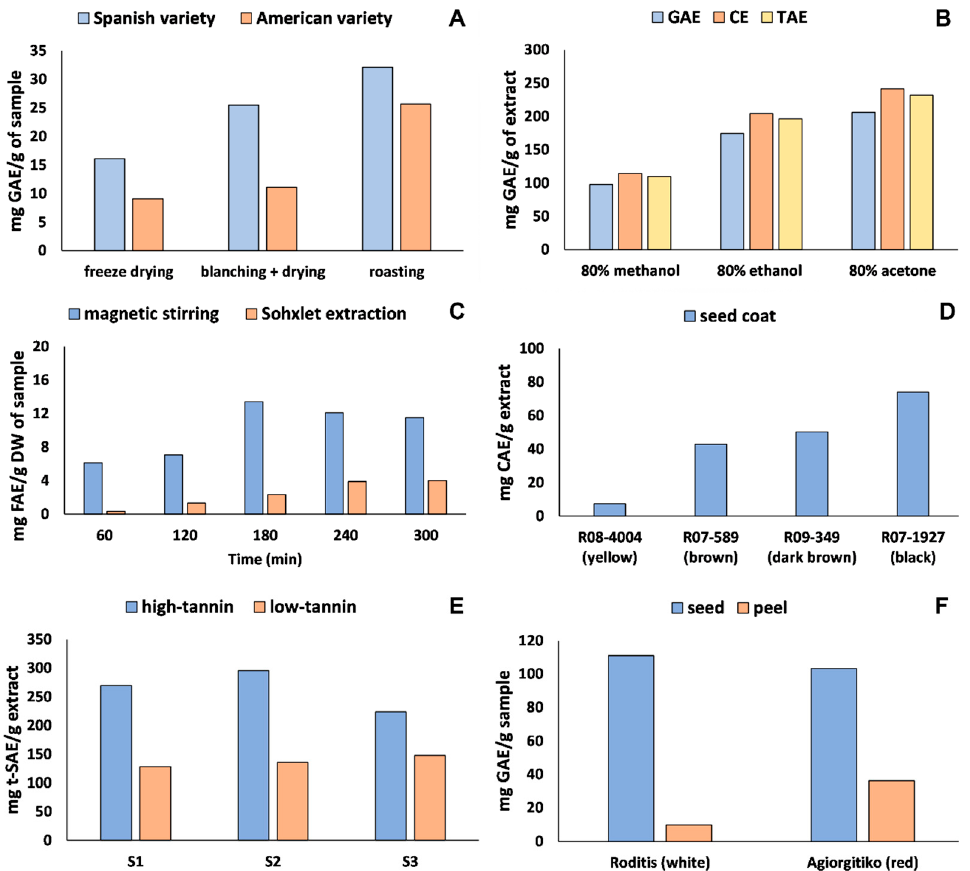
Figure 4. Total phenolics in selected plant food by-products. ( A ) Almond skin [191]; ( B ) hazelnut skin [192]; ( C ) rice husk [193]; ( D ) soybean coat [194]; ( E ) canola (high-tannin) and rapeseed (low-tannin) hull [195], S1, S2, and S3 are sample 1, 2, and 3, respectively; ( F ) grape seed and peel [196]. Abbreviations: GAE, gallic acid equivalents; CE, catechin equivalents; TAE, tannin acid equivalents; FAE, ferulic acid equivalents; CAE, chlorogenic acid equivalents; and SAE, sinapic acid